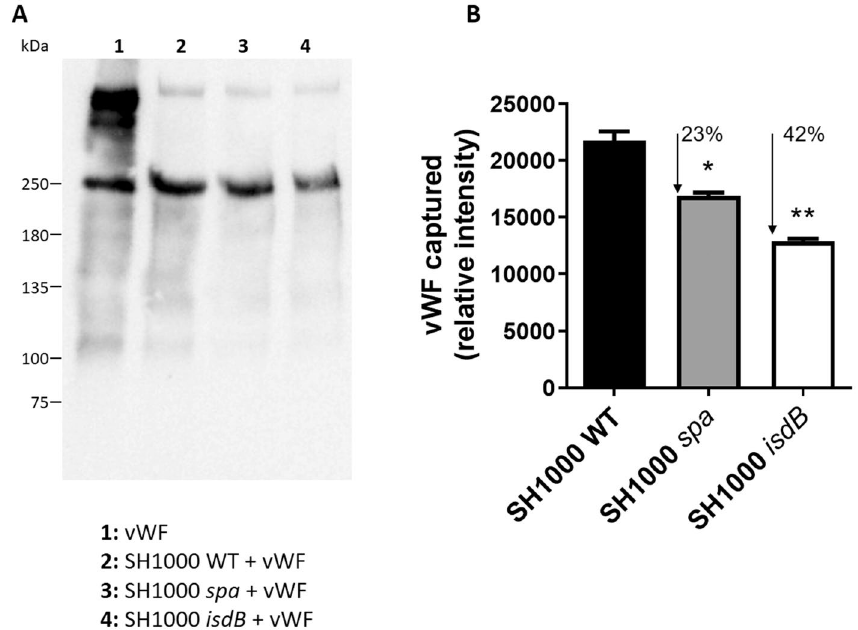
Figure 2. Capture of vWF by S. aureus cells. (A) S. aureus SH1000 WT and its spa or isdB mutant were grown in RPMI to stationary phase. The staphylococcal cells were incubated with purified human vWF (5 µg/ ml) and bacteria-bound protein was released by extraction buffer and subjected to SDS-PAGE and Western Immunoblotting. 2 µg of purified vWF was loaded as control. The membrane was probed with a polyclonal rabbit vWF antibody followed by HRP-conjugated goat anti-rabbit IgG. Molecular masses of standard proteins are indicated on the left. The full-length blot is presented in Supplementary Fig. S3. (B) Densitometric analysis of vWF bound to S. aureus WT and its isogenic spa or isdB mutant. Statistically significant differences are indicated (*, P < 0.05; **, P < 0.01). The reported data are the mean values ± SD from three independent